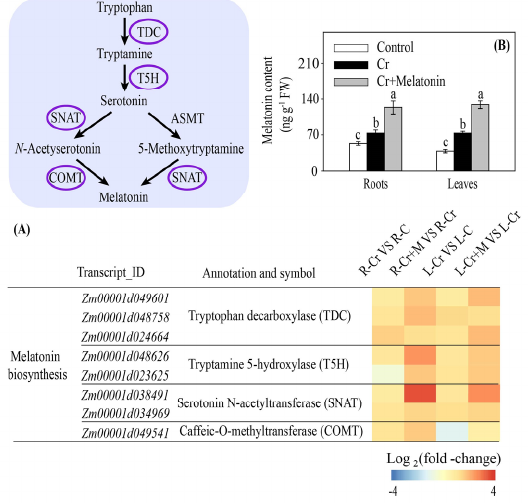
Figure 8. Melatonin and Cr induced changes in gene transcripts involved in melatonin biosynthesis in maize roots and leaves ( A ). The effect of melatonin on endogenous melatonin content in maize under Cr stress ( B ). Different letters in one measure (roots or leaves) denote significant differences at p < 0.05. Data are shown as mean ± SE ( n =